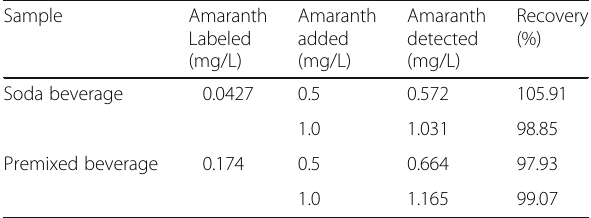
Table 3 Results of the spiked recovery experiment